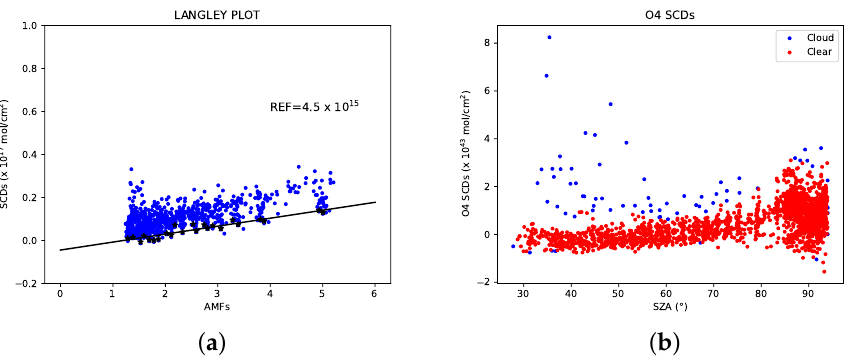
Figure 2. ( a ) Modified Langley plot and ( b ) O 4 SCDs data filtering for TROPOGAS during the Bologna inter-comparison campaign. Results for NO 2 cross sections at 298